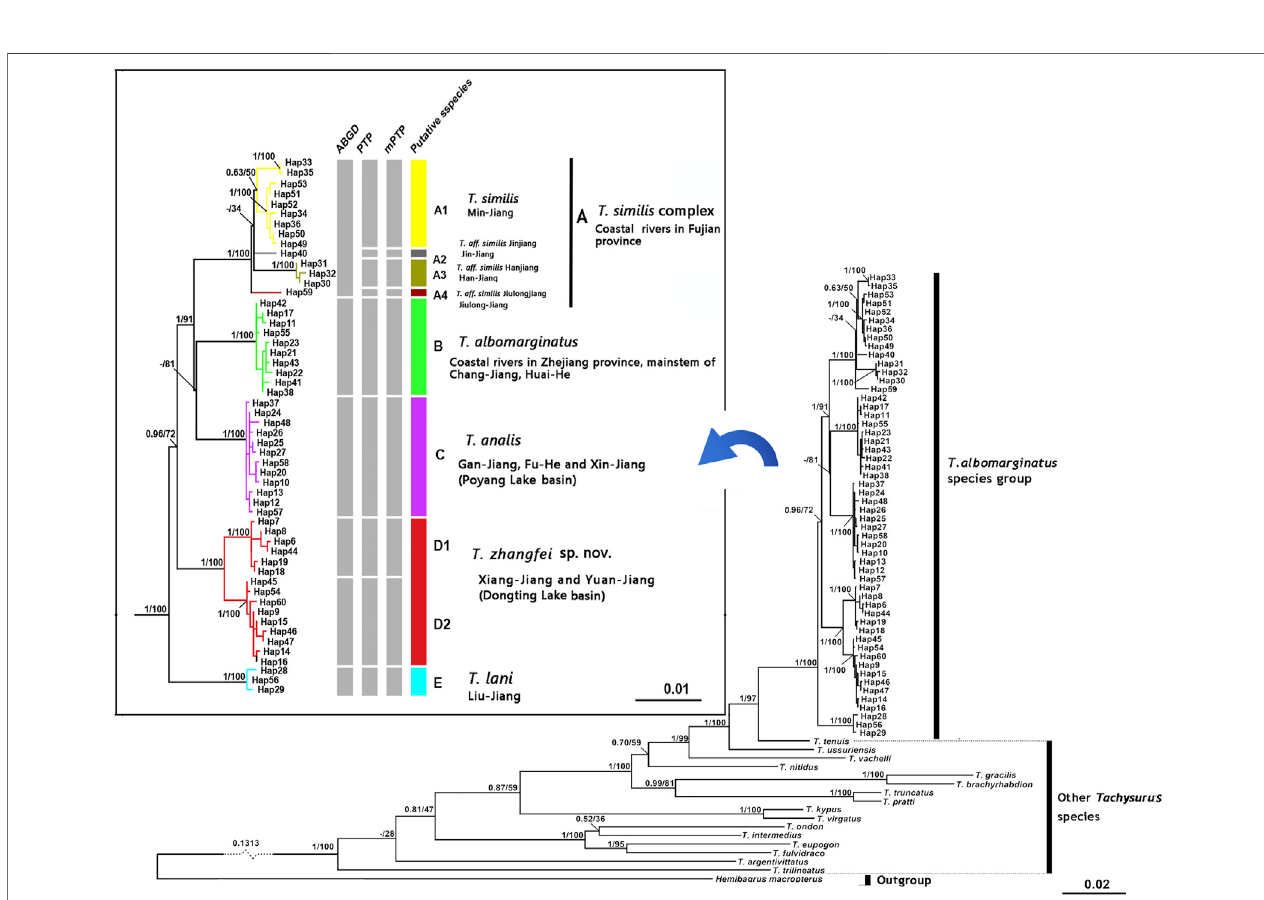
FIGURE 2 | Bayesian tree based on combined genes for the T. albomarginatus species group. Values on the left of the nodes indicate posterior probabilities and bootstrap supports of Bayesian inference/maximum likelihood for major lineages. The results of species delimitation are shown on the right.